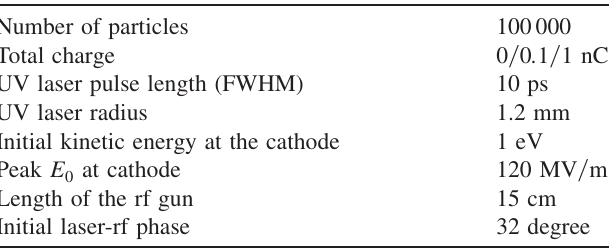
TABLE II. Parameters used in PARMELA simulation. These values are computed at the position z ¼ 61 mm , which is the center of the full cell, and the radius r 0 ¼ 9 : 5 mm . (cid:5) 1 - hole , (cid:5) 2 - holes is the rms beam size of the one-hole model and the two-holes model at the same longitudinal position ( z ¼ 61 mm ), respectively. ’ 0 is the phase of the rf field. Initial beam sizes are edge values. The input beam has a beer can shape. There is no initial thermal emittance.